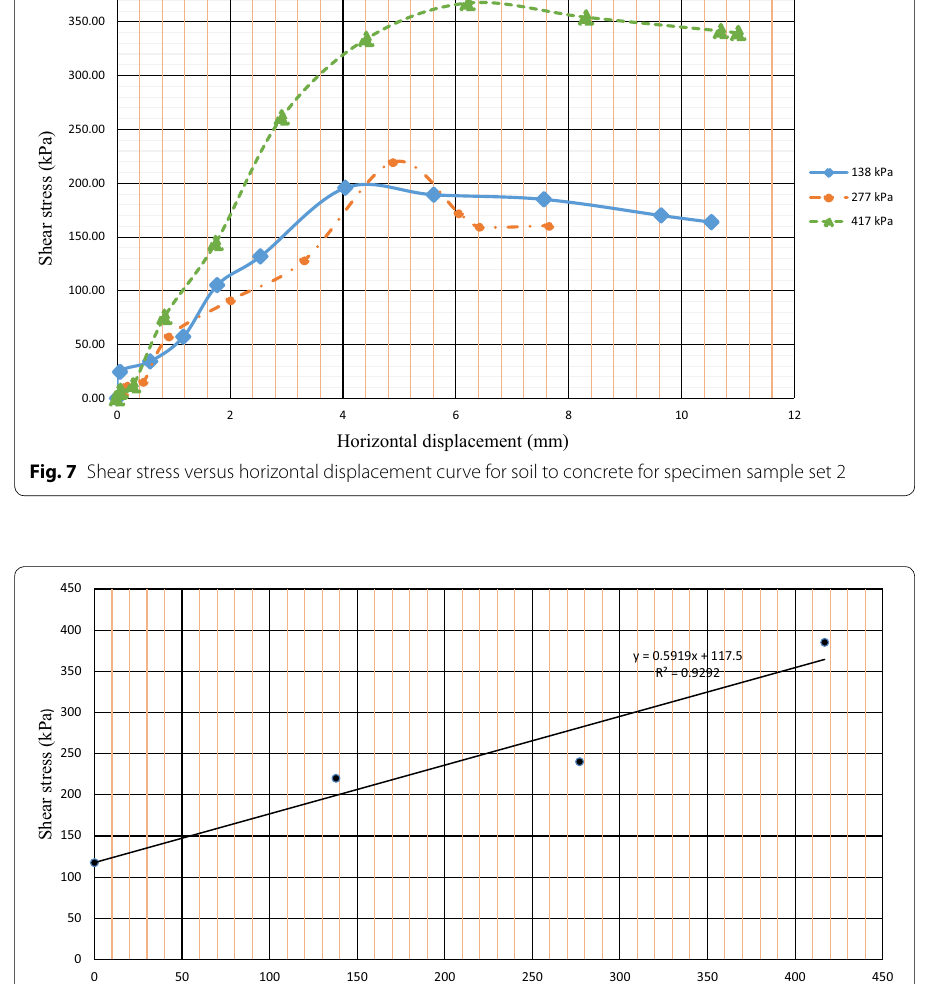
Fig. 8 Shear versus normal stress plot using conventional approach for soil concrete interface for sample